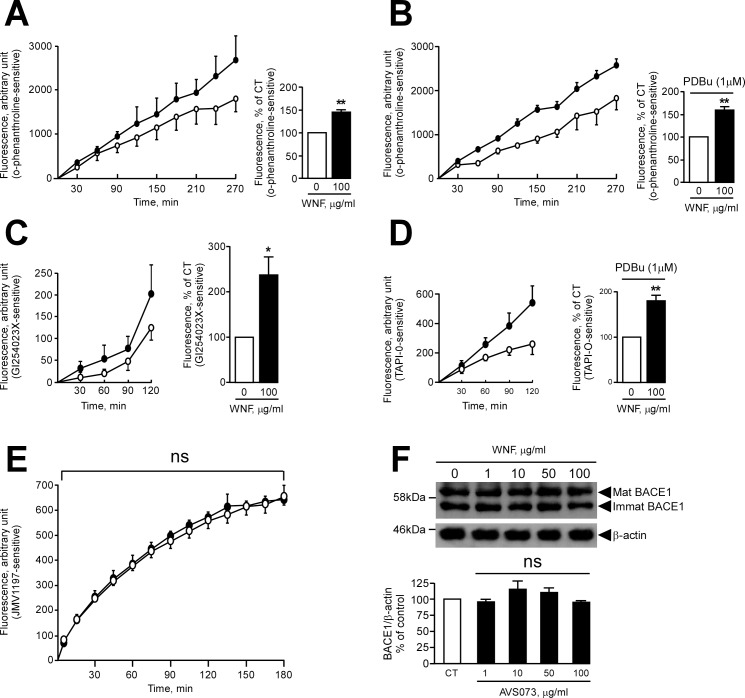
WNF increases α-secretase catalytic activities in HEK293 cells without interfering with BACE1 activity and expression.(A-D) Cultured ADAM10-HEK293 (A, C) or ADAM17-HEK293 (B, D) cells were treated in duplicate with (black circles) or without (control, white circles) WNF (100μg/ml in DMEM/1% FBS) for 16 hours at 37°C. Cells in (B) and (D) were then treated with PDBu (1μM) for 2 hours. Duplicates were subsequently incubated in PBS with or without o-phenanthroline (100μM) (A-B), GI254023X (10μM) (C) or Tap-I (10μM) (D) for 30 min. JMV2770 (10μM) was then added, media (100μl) were collected at the indicated time points and fluorescence was recorded. Values in curves represent the means ± SE of the specific (inhibitor-sensitive) fluorescence recorded during independent experiments (n = 4). For histograms, values in black bars are expressed as the percent of control (white bars) at each time and are the means ± SE of 4 independent experiments. *p<0.002; **p<0.0001. (E) Cultured 1D4-BACE1-HEK293 cells were treated for 16 hours in the absence (control, white circles) or in the presence of WNF (100μg/ml in DMEM/1% FBS, black circles). Cells were then assayed for their β-secretase activity. Values in curves represent the means ± SE of the specific (JMV1197-sensitive) fluorescence recorded during 3 independent experiments. ns, non-statistically different. (F) Cultured wild-type HEK293 cells were incubated without (control) or with the indicated concentrations of WNF (in 1ml DMEM/1% FBS) for 16 hours at 37°C. Cells were then collected and endogenous BACE1 and β-actin were analyzed by Western blot. Immunoblots illustrate representative gels and histograms correspond to the statistical analysis for all experiments. All bars correspond to the densitometry analyses (BACE1 normalized with β-actin), are expressed as a percentage of control (white bars, non treated cells) taken as 100 and are the means ± SE of 4 independent experiments. ns, non-statistically different.